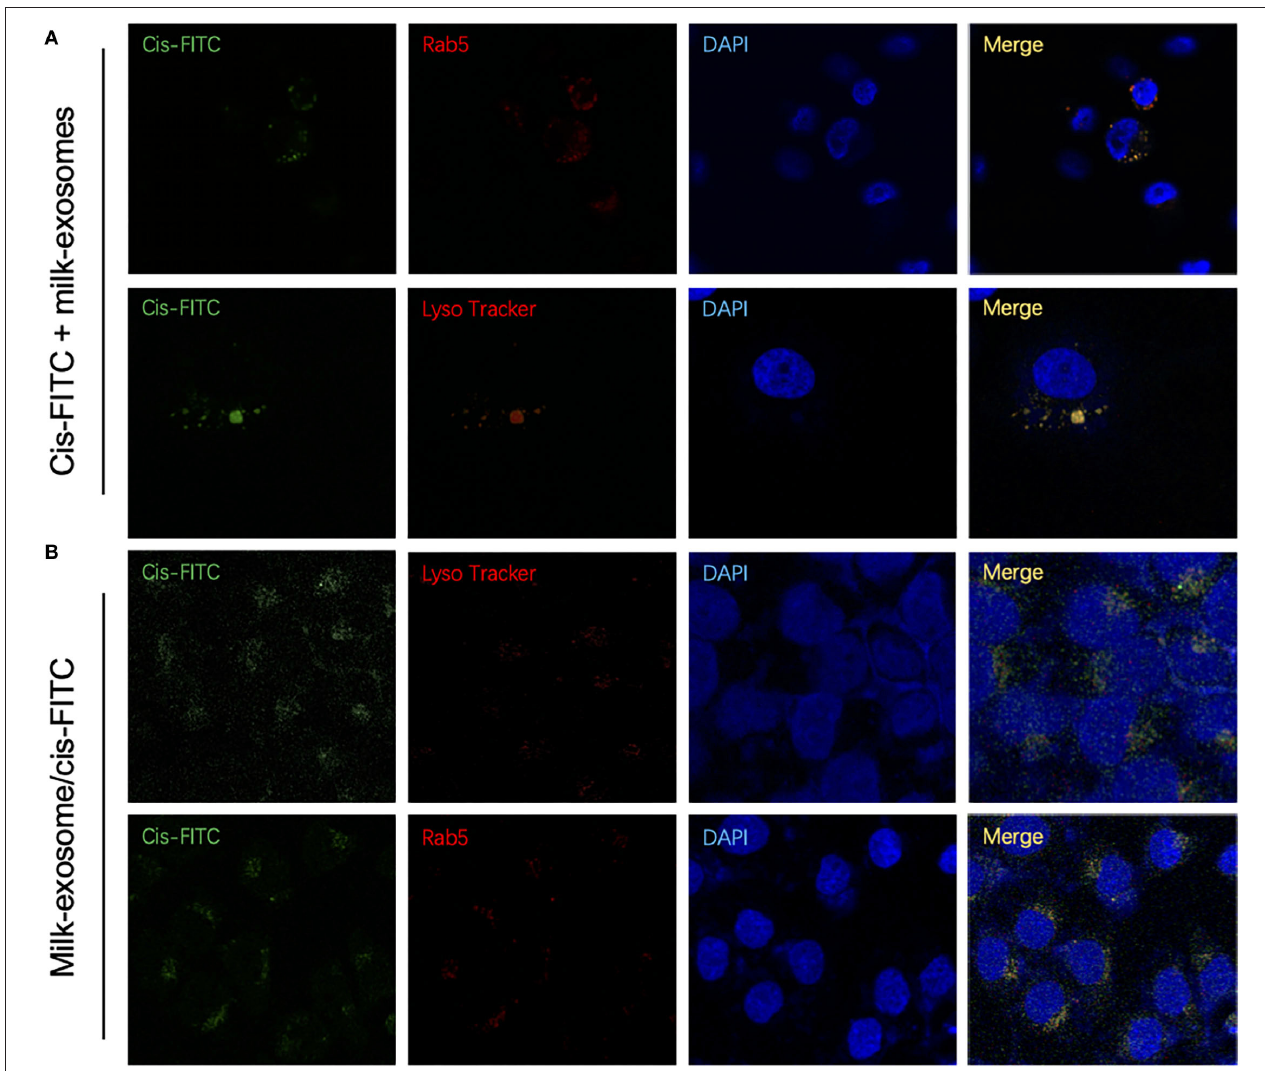
FIGURE 8 | Cytosolic localization studies between cis-FITC and endosomes of cisplatin delivery with or without milk-exosomes. (A) Intracellular trafficking of internalized cis-FITC monitored by co-localization with the endosome marker Rab5 (red fluorescence) and lysosome marker LysoTracker Red (red fluorescence) by confocal microscopy. Green represents cis-FITC, and blue represents DAPI stained nuclei. (B) Intracellular trafficking of internalized milk-exosome/cis-FITC monitored by co-localization with the endosome marker Rab5 (red fluorescence) and lysosome marker LysoTracker Red (red fluorescence) by confocal microscopy. Green represents cis-FITC, and blue represents DAPI stained